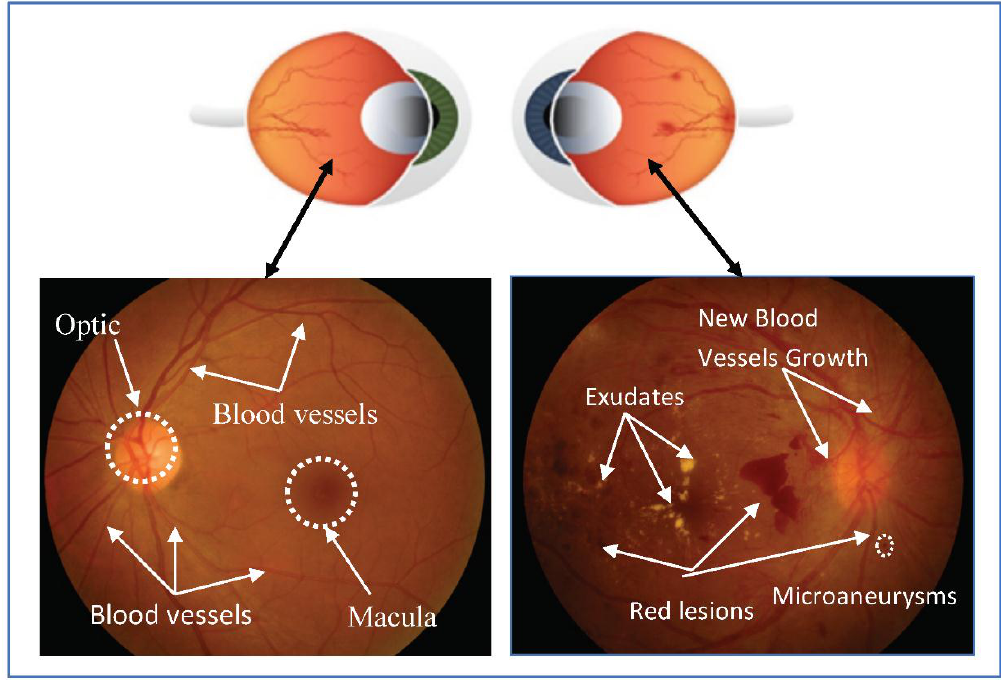
Figure 1. Healthy fundus image and diabetic retinopathy image.